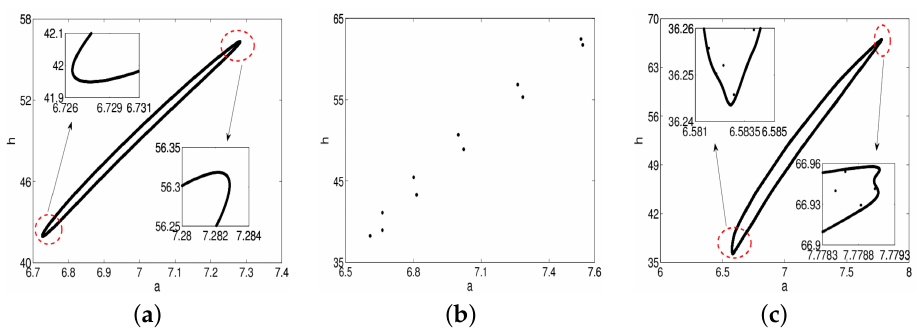
Figure 4. Phase portraits for different values of τ corresponding to Figure 3a. ( a ) τ = 4.311; ( b ) τ = 4.3223; ( c ) τ =